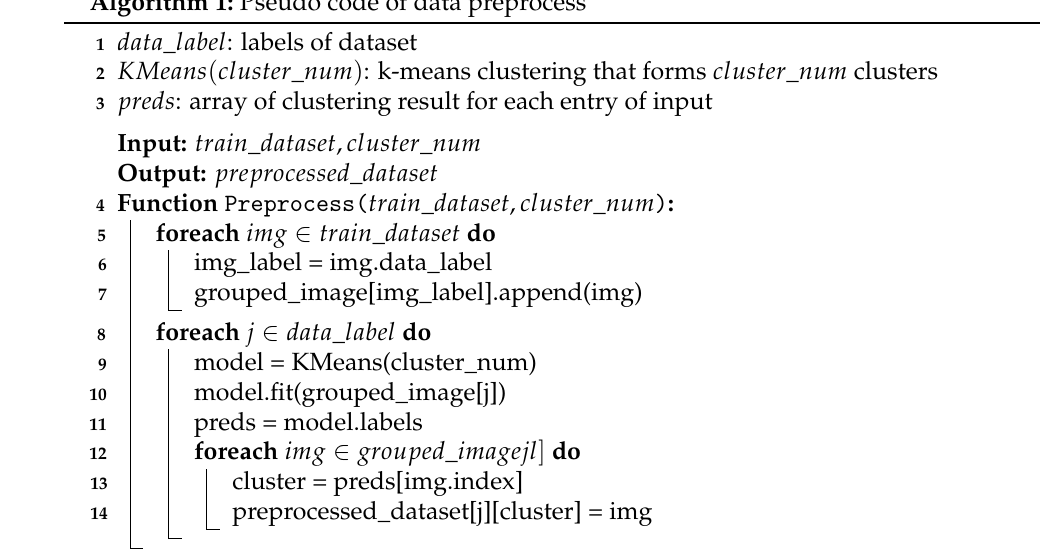
Algorithm 1: Pseudo code of data preprocess